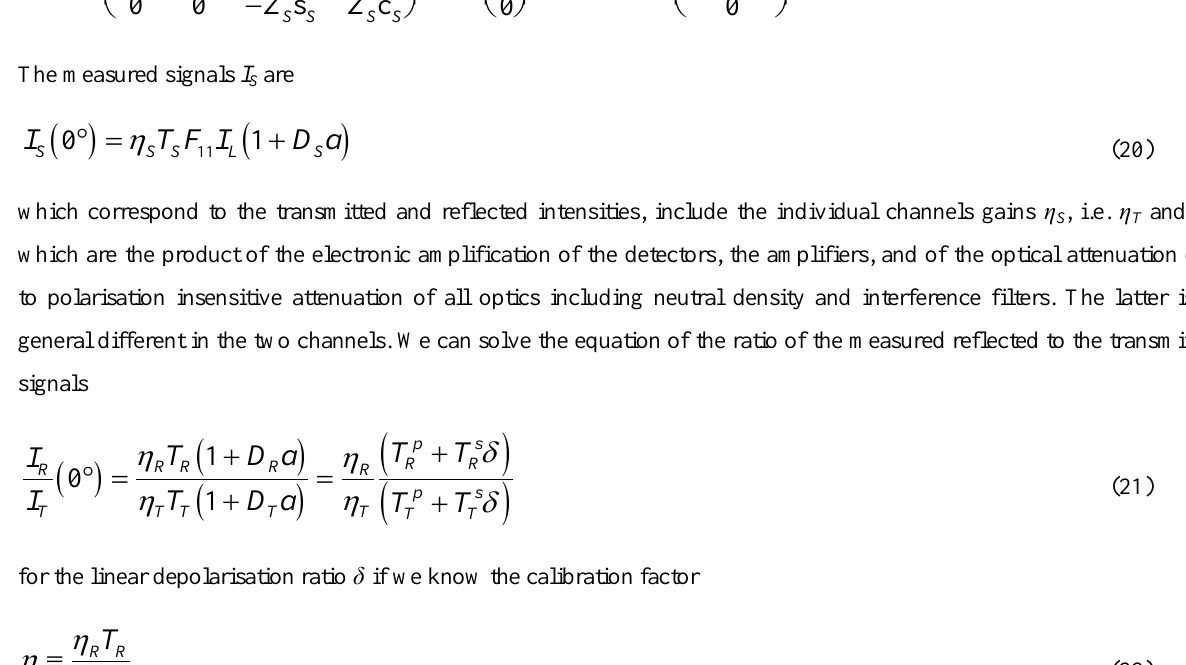
(with reflectance T and transmittance T for unpolarised light) and the transmission parameters of the polarising beam R T p , T s , T p , and T s for the correction of its crosstalk. We could get the calibration factor η already with the splitter T T T R R measurements in Eq. (21) if the light incident on the analyser were unpolarised, i.e. a = 0. Otherwise, η can be determined by means of calibration measurements, e.g. by rotating the PBS including the detectors by +45° or −45° about the optical axis (Eq.